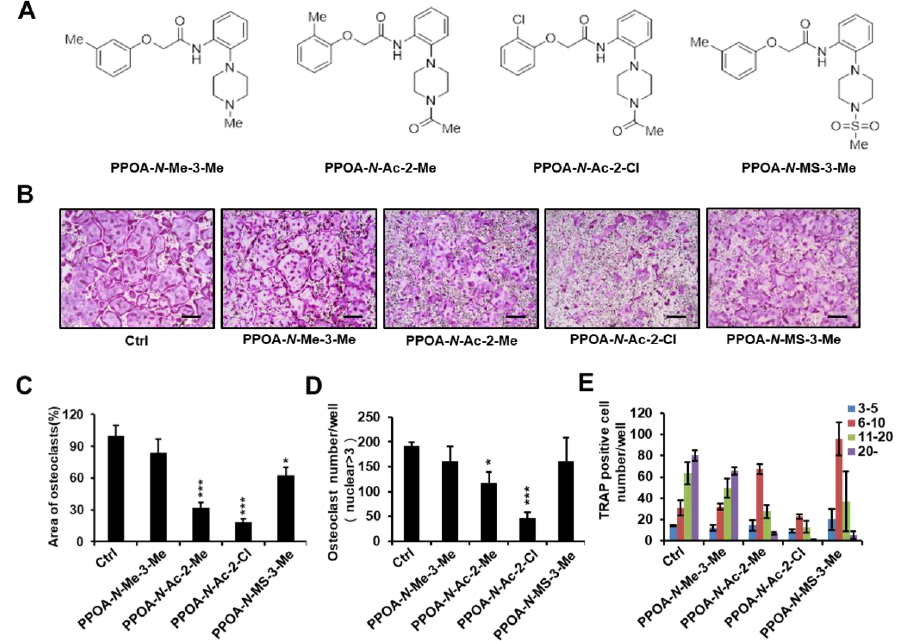
Figure 1. ( A ) Structures of PPOA- N -Me-3-Me, PPOA- N -Ac-2-Me, PPOA- N -Ac-2-Cl, and PPOA- N -MS-3-Me. ( B ) Bone marrow monocytes (BMMs) were differentiated into osteoclasts by treatment with macrophage colony-stimulating factor (M-CSF) (30 ng/mL) and receptor activator of nuclear factor kappa- Β ligand (RANKL) (50 ng/mL) in the presence of PPOA derivatives (5 μM each ). ( C − E ) Tartrate-resistant acid phosphatase (TRAP)-positive cells possessing more than three nuclei in panel ( B ) were calculated using Image J software. Scale bar = 200 μ m. The spread areas ( C ) and number ( D , E ) of TRAP-positive cells were calculated using Image J. * p < 0.05, and *** p < 0.001 indicate the statistically significant difference compared to vehicle-treated control.